Question: Provide a publication-style caption for this figure.
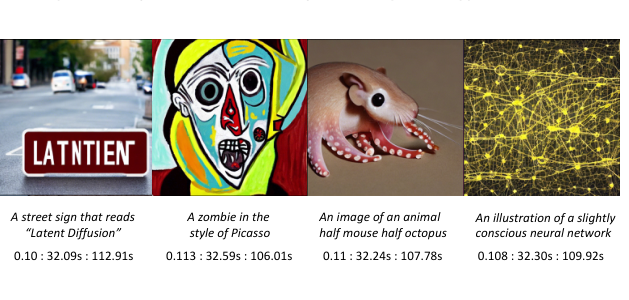
Answer: Performance results with different prompts. The time cost results are organized as “sparsity : plaintext run- ning time : HE-Diffusion running time". Experiments are conducted on one A100 GPU.